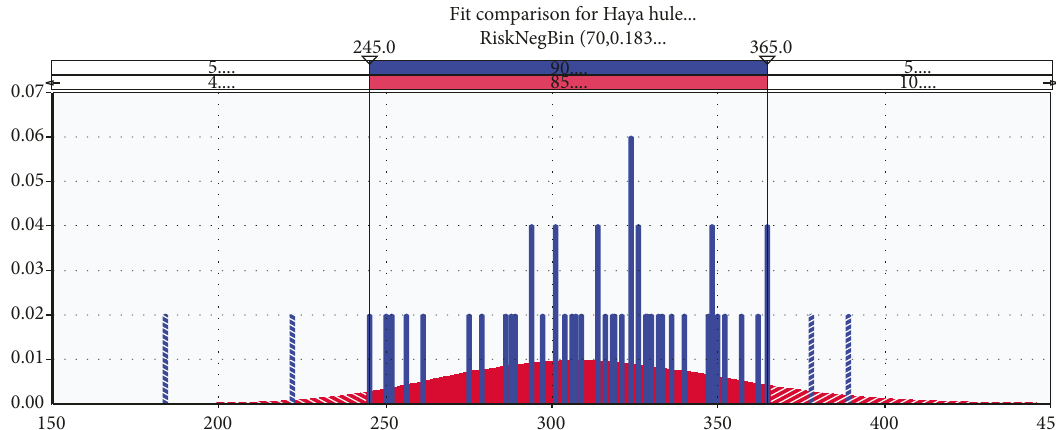
Figure 2: The probability distribution of passengers departed per tramcar for peak hours at Haya Hulet 1 station in the W-E corridor.